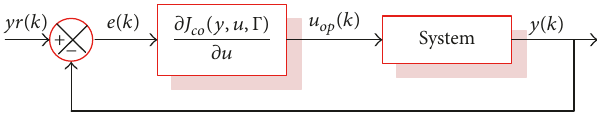
Figure 1: Problem principle of optimal